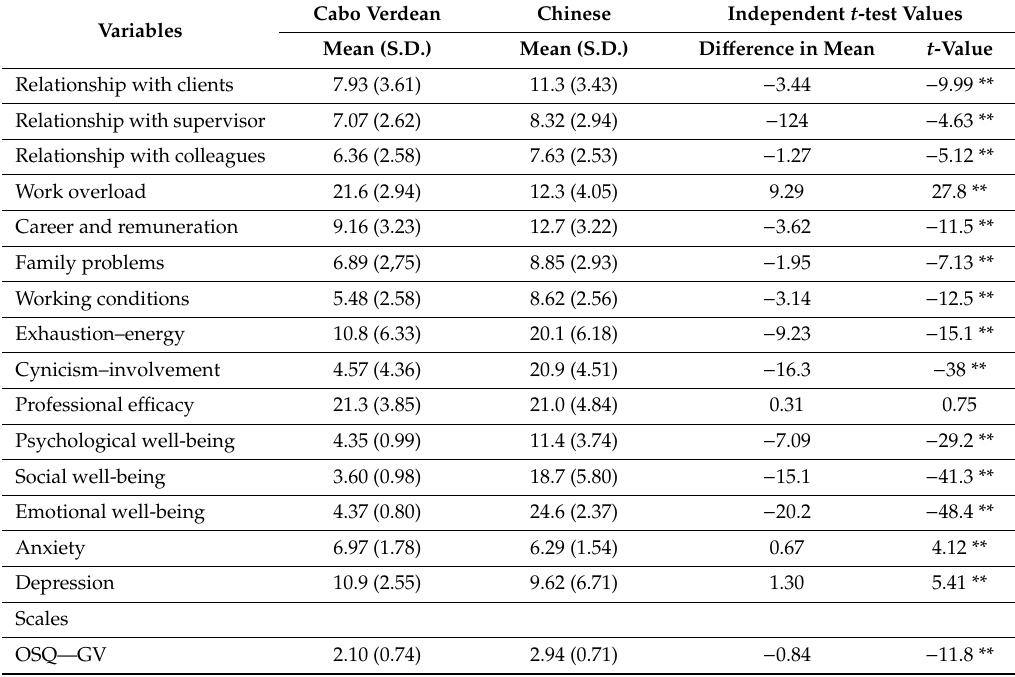
Table 4. Mean di ff erences between the Cabo Verdean ( n = 263) and the Chinese employees ( n = 177).